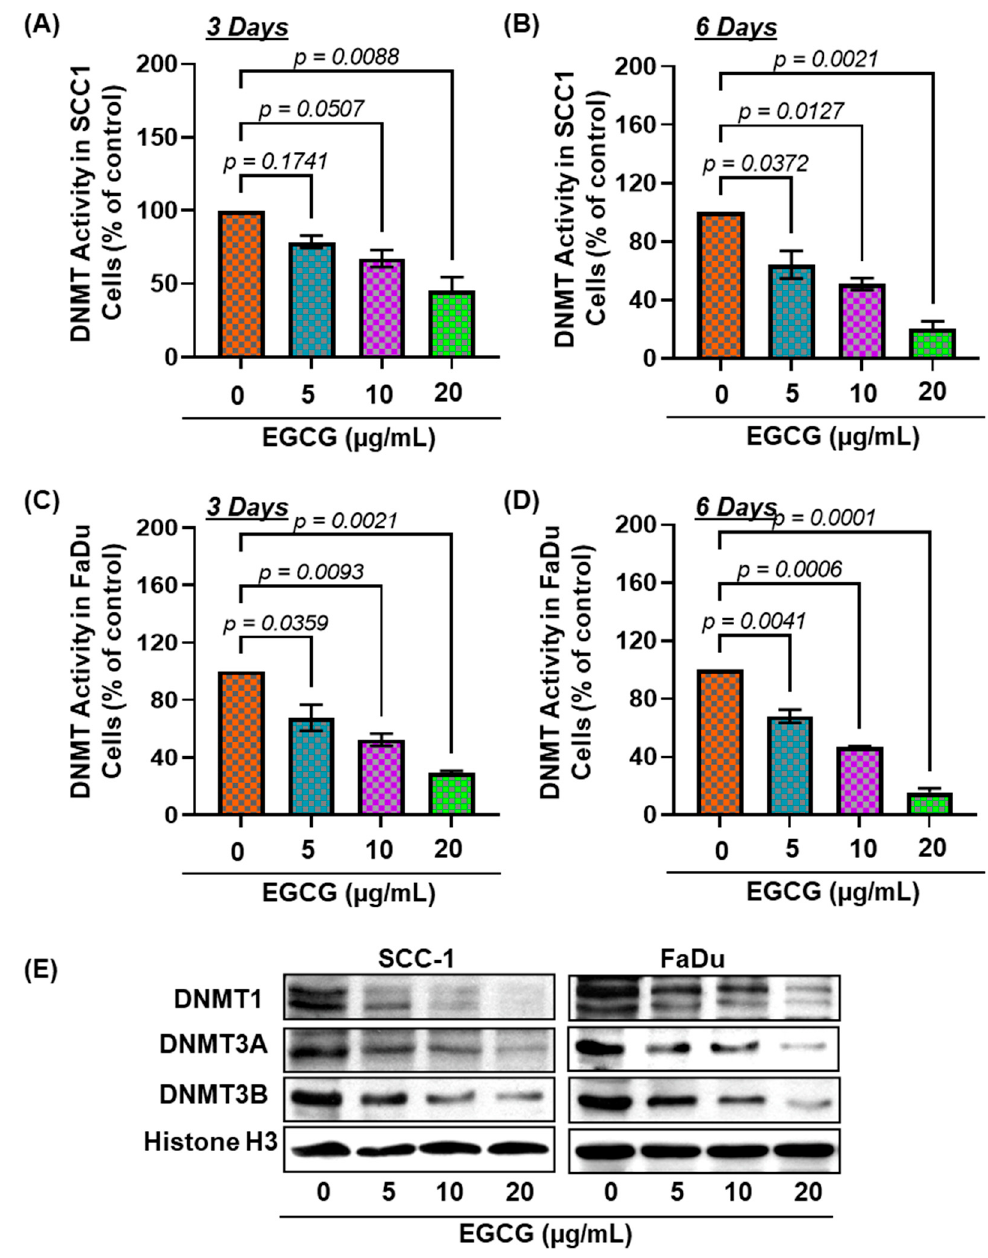
Figure 3. EGCG treatment inhibits DNA methyltransferases in HNSCC cells. Total DNMT activity in nuclear extracts of SCC-1 ( A , B ), and FaDu ( C , D ) was determined using the DNA methyltransferase activity assay kit. Data are presented in terms of percentage versus non- EGCG-treated controls, which were assigned a value of 100%, and as means ± S.E.M from three independent experiments. Significant differences were observed versus non-EGCG-treated controls. The levels of DNMT1, DNMT3a, and DNMT3b in nuclear lysates of SCC-1 and FaDu cells were determined using Western blot analysis after treating the cells with EGCG for 6 days ( E